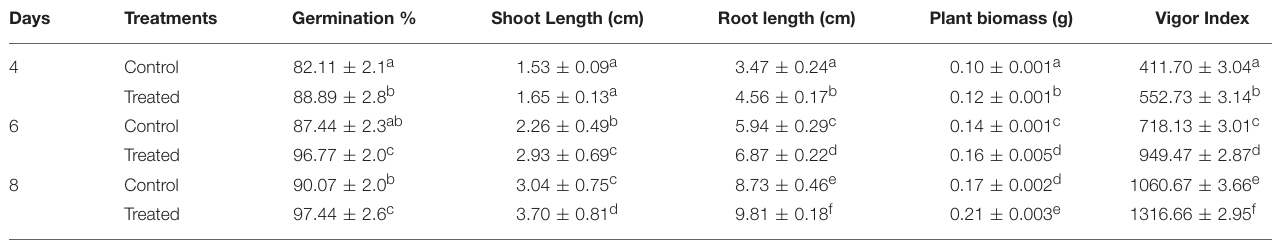
TABLE 3 | Biopriming effect of MSSRFD41 on finger millet seedling